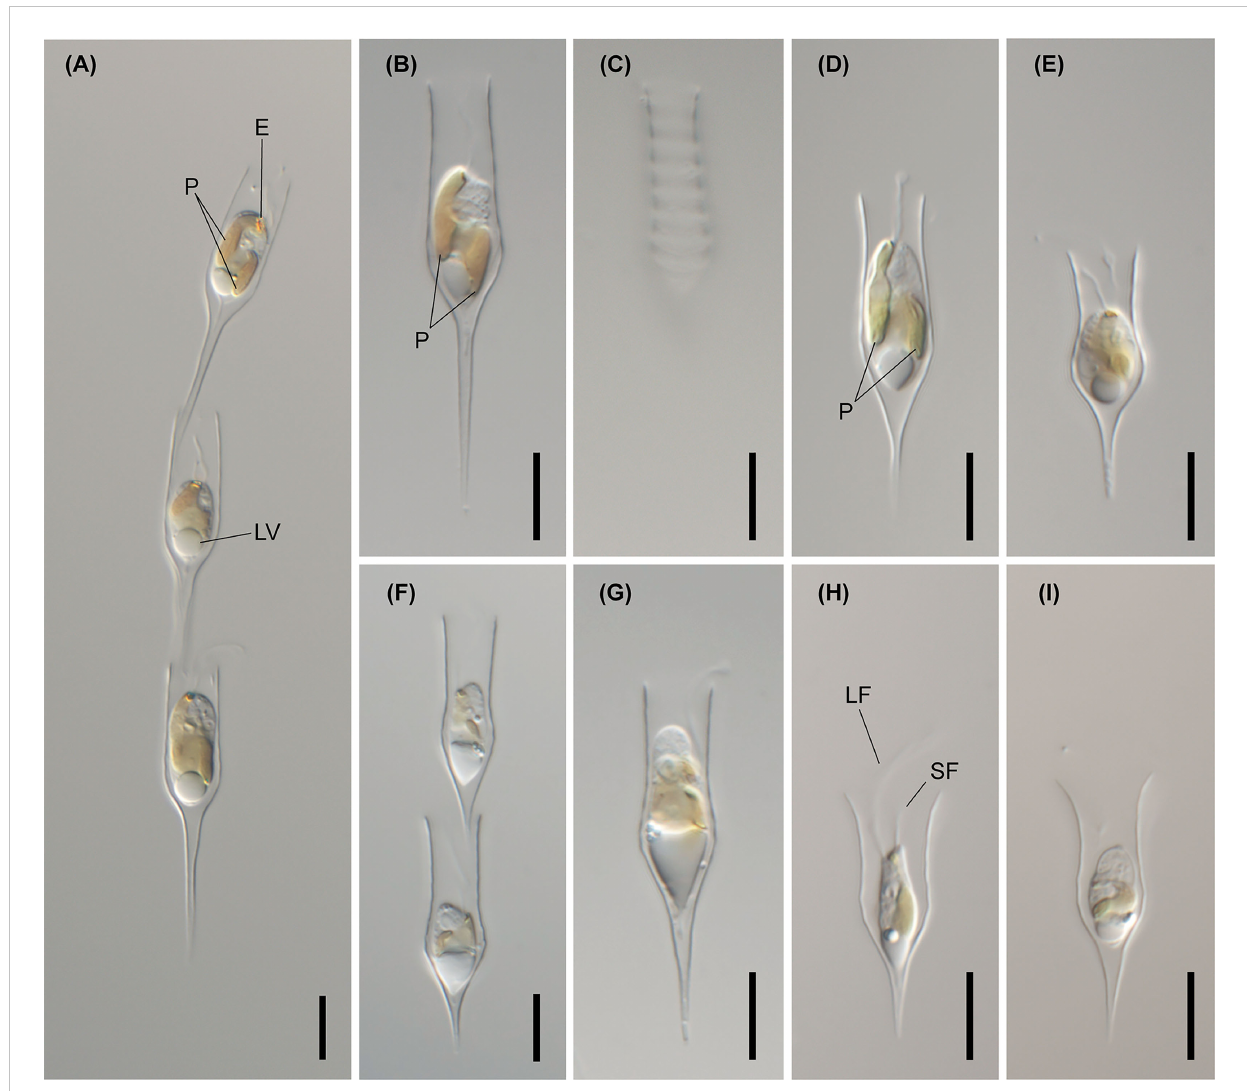
FIGURE 4 Light micrographs of D. bavaricum . Images showing a cell having a long (LF) and short fl agella (SF), plastids (P), eyespot (E) and leucosin vesicle (LV) contained in a lorica. (A – E) Images of D. bavaricum CCMP3270. (F, G) Images of D. bavaricum CCMP3054. (H, I) Images of D. bavaricum CCMP2884. Scale bars = 10